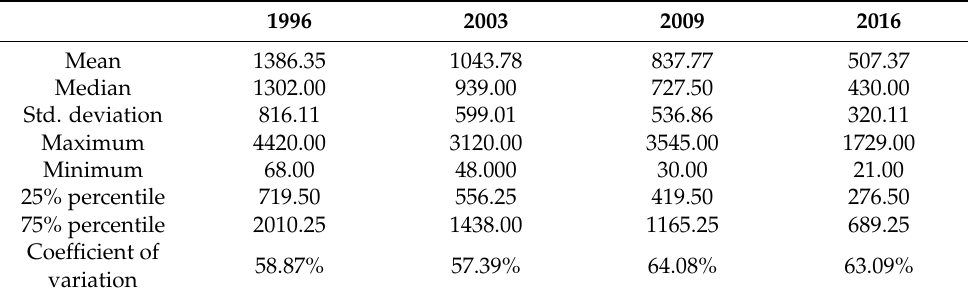
Table 1. Statistical results of STRT from 1996 to 2016 (unit: min).